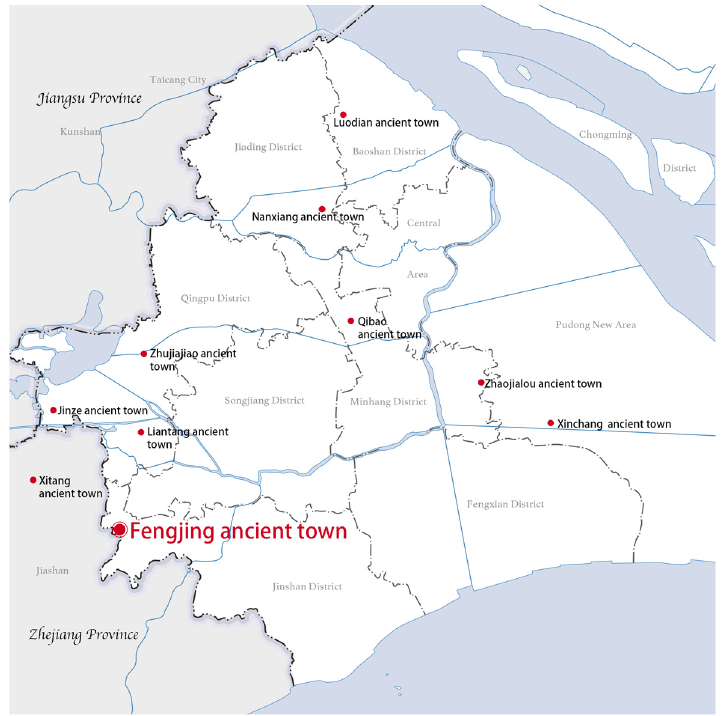
Figure 1. Geographical location of Fengjing Ancient Town (source: authors).